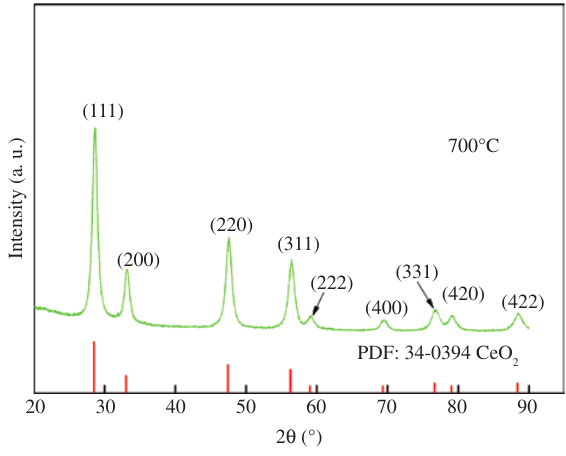
Figure 2: The X-ray diffraction (XRD) patterns of the prepared CeO by ultrasonic spray pyrolysis of CeCl 2 atmosphere.